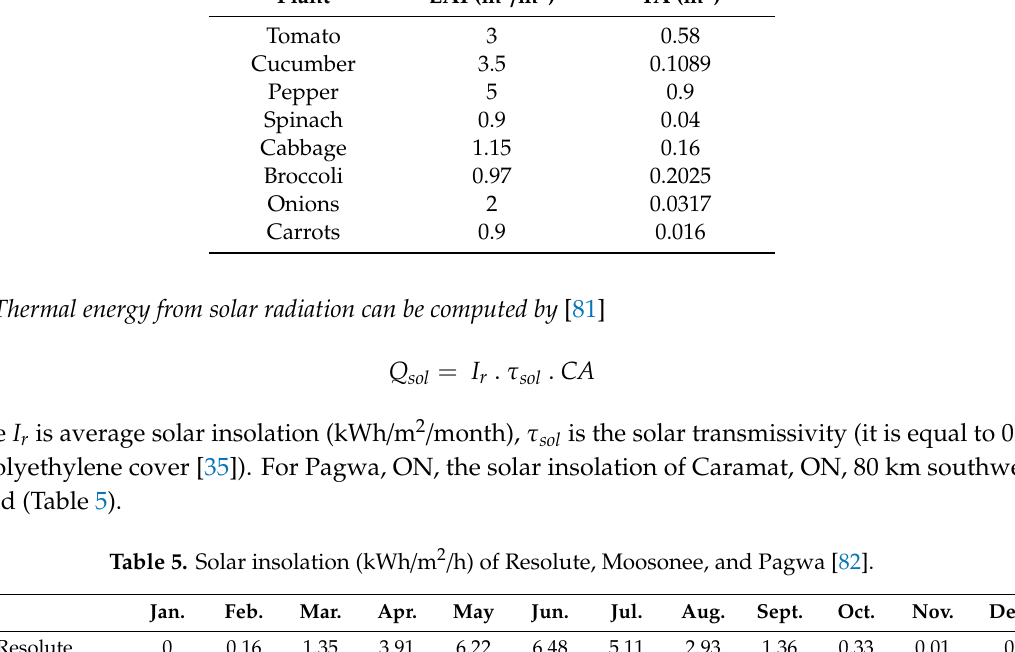
Table 4. Leaf area index ( LAI ) and soil area per plant ( TA ) for di ff erent vegetables [71,78–80]. Plant LAI (m 2 / m 2 )